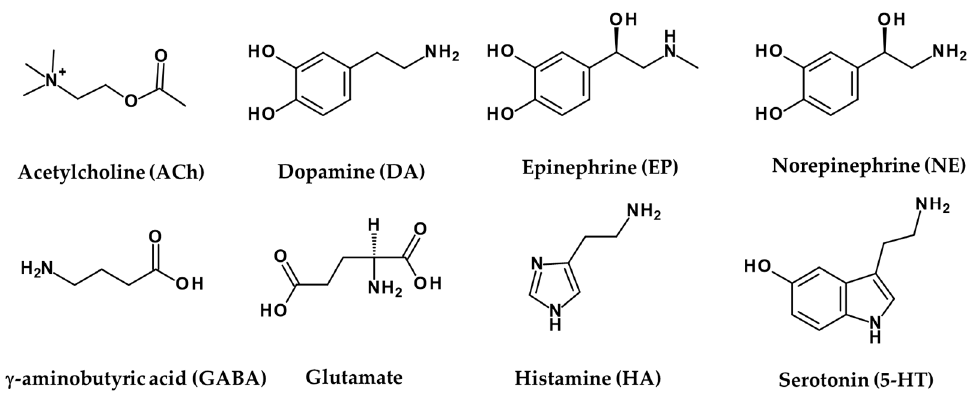
Figure 2. Amine Figure 2. Amine neurotransmitters.